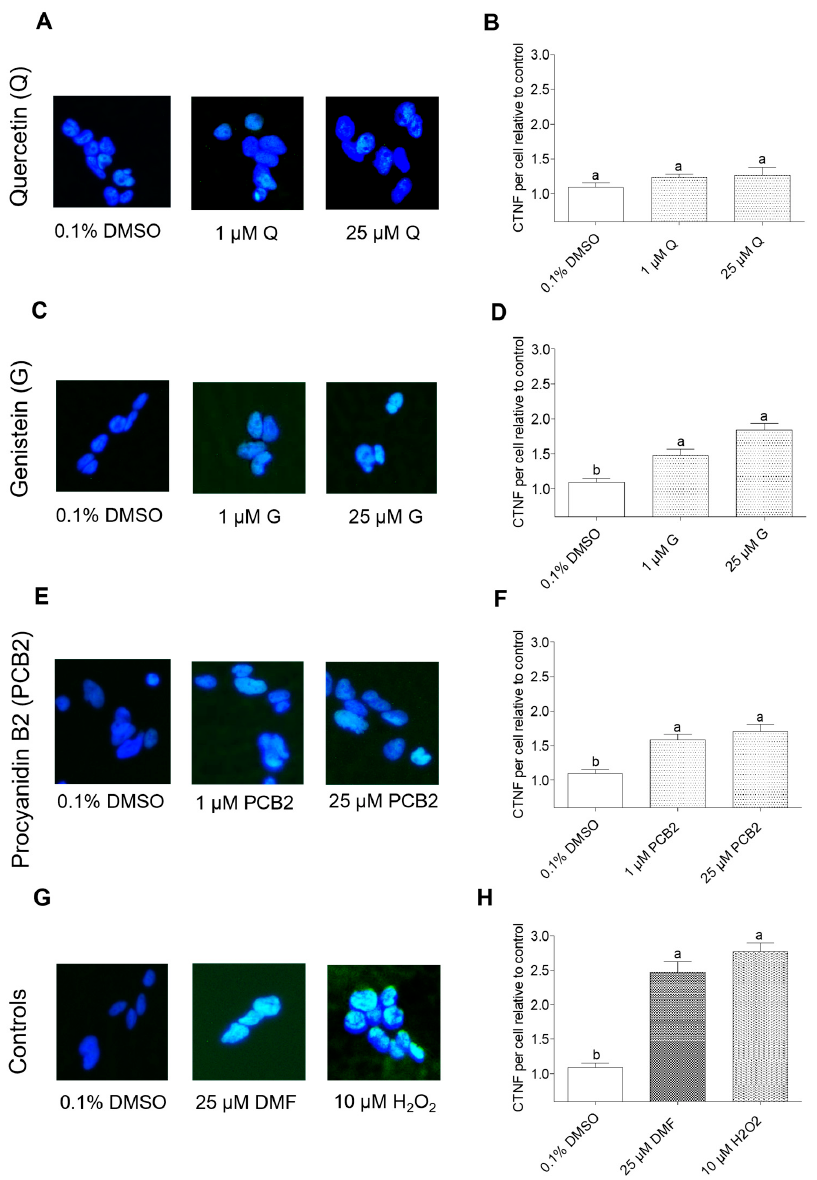
Figure 10. Effect of quercetin ( A , B ), genistein ( C , D ), procyanidin B2 ( E , F ) and controls ( G , H ) on p-Nrf2 nuclear translocation in BEAS-2B cells measured by immunofluorescence assay. Cells were treated with 1 µ M and 25 µ M of quercetin, genistein, or procyanidin B2 for 3 h. DMF (25 µ M) and H 2 O 2 (10 µ M) were used as the positive controls, and 0.1% DMSO was used as the vehicle control. Phosphorylated Nrf2 (Ser40) (p-Nrf2) was labeled with specific antibodies and nuclei were stained with DAPI. Nuclei were imaged by fluorescence microscopy ( × 100 magnification). The corrected nuclear fluorescence (CTNF) levels per nucleus were quantified using at least 30 nuclei per treatment to measure the level of p-Nrf2 nuclear translocation by immunofluorescence analysis. CTNF per nucleus was measured by ImageJ software (Version 1.53k, National Institute of Mental Health, Bethesda, MD, USA). Three independent studies were performed, and results were expressed as mean ± standard deviation. Statistical analysis of data was performed by one-way ANOVA and mean comparison was done by Tukey’s mean comparison method ( α = 0.05) using Minitab 19 statistical software (LLC, Pennsylvania, USA). Mean values that do not share similar letters in bar graphs are significantly different ( p < 0.05). Abbreviations: NNKAc: